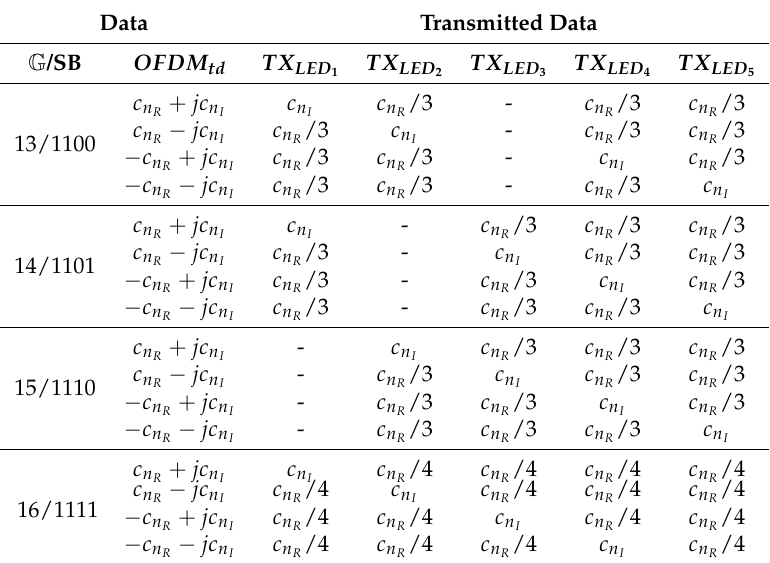
Data Transmitted